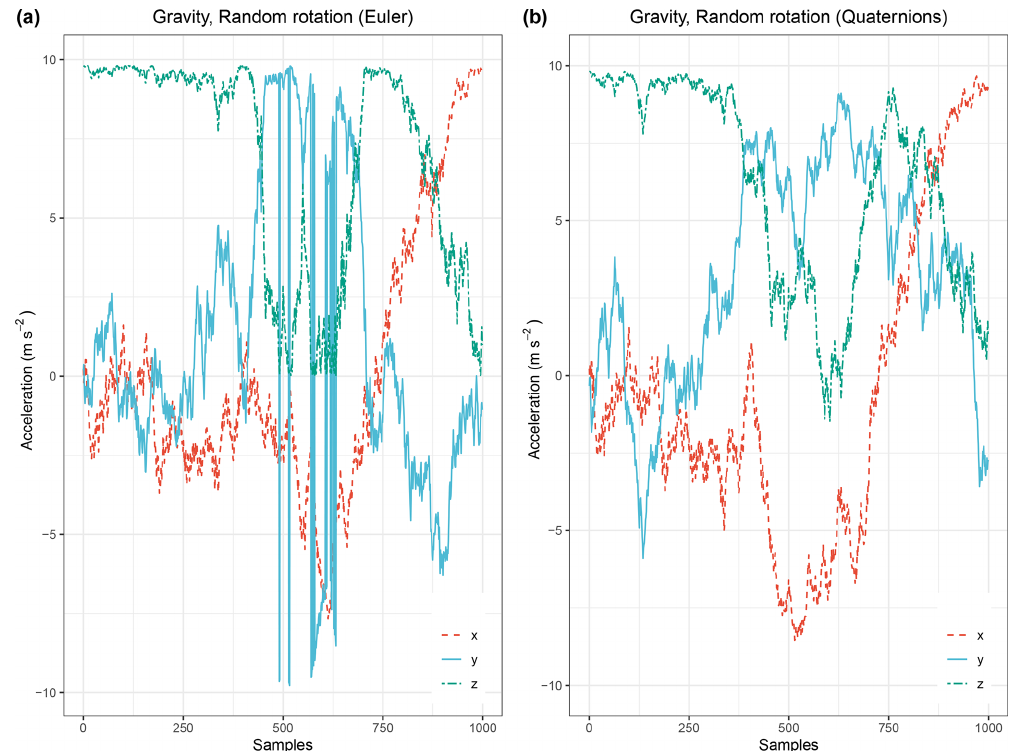
Figure G1. Random rotation of the static vector of gravity. [ g x ,g y ,g z ] = [ 0 , 0 , 9 . 81 ] ms − 2 in the gravity frame of reference as expressed in the body frame of a randomly rotating rigid body ( dt = 0 . 01s). Panel (a) demonstrates the rotation calculations with the usage of Euler angles. Gimbal lock occurs after the 400 iterations. Panel (b) shows the same rotation series calculated via quaternions. No Gimbal lock occurs and the result is easy to interpret as it is based on the use of the measured body frame angular velocities.